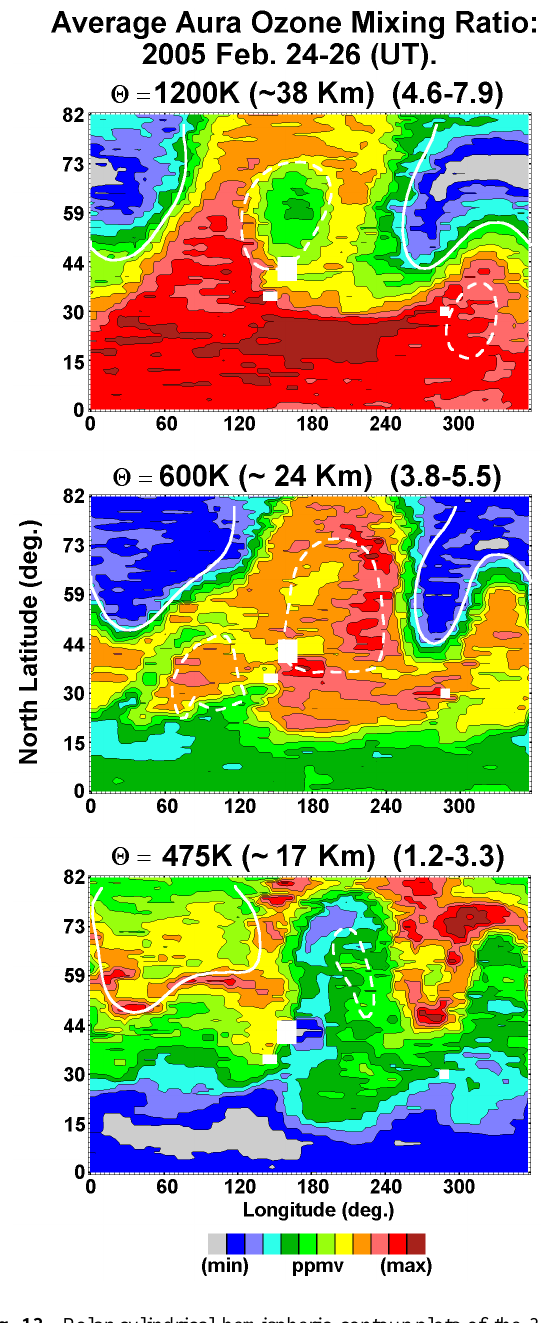
Fig. 13. Polar cylindrical hemispheric contour plots of the 3-day average mixing ratios of ozone (Aura MLS) for three heights. These are for a day (25 February) within the 25 February “warming event” defined in Sect. 3: “the end of a warming trend or “temperature disturbance” (typically ∼ 10 days in duration) as indicated by zonal mean MetO temperatures at 60–70 ◦ N and 10hPa”. The edge of the polar vortex as determined by the Q-diagnostic using MetO (data assimilation model) is shown with a solid white line (see text); the edge of the anticyclone is located with a dashed white